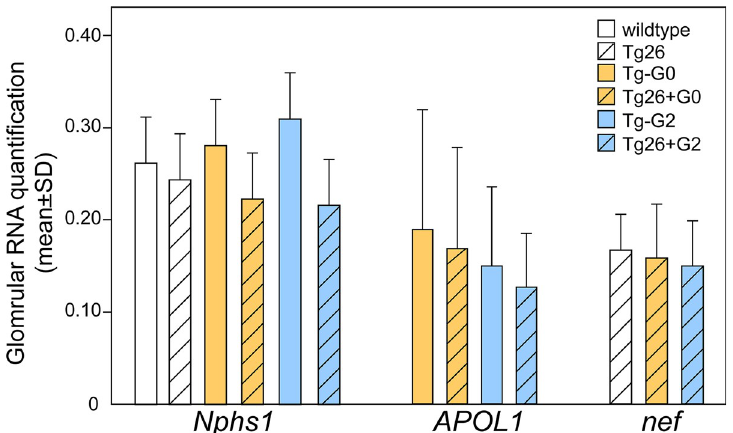
Fig 3. Transgene expression levels were not altered in dual transgenic mice. RNA from isolated glomeruli were quantified from normal (wildtype) n = 6, Tg26 n = 8, Tg-G0 n = 7, Tg-G2 n = 5, Tg26+G0 n = 6, Tg26+G2 n = 7. Nphs1 (Nephrin) expression was used as a reference podocyte gene. Data are 1/ Δ Ct normalized to Tuba1a (Tubulin) levels.